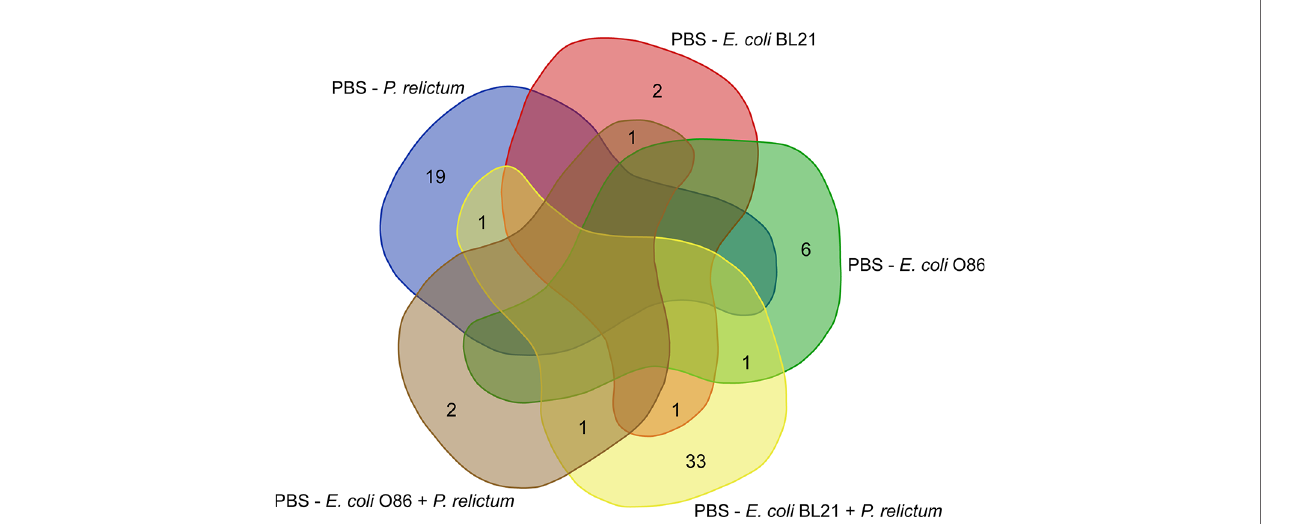
FIGURE 5 | Comparison of unique and shared taxa across different experimental groups. Venn diagram showing the common and different taxa with signi fi cant changes in their abundance between vaccinated and infected groups, compared to the mock-vaccinated group (PBS).